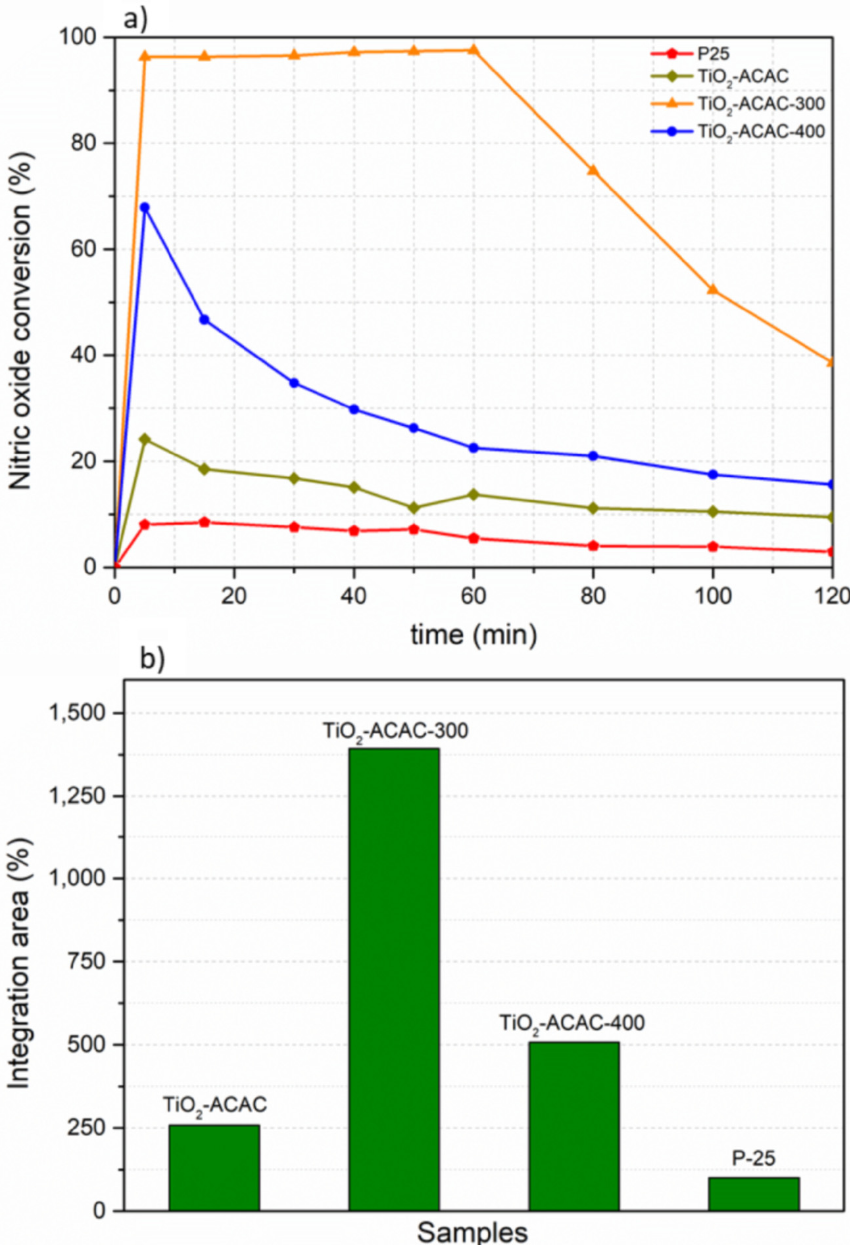
Figure 8. ( a ) Photocatalytic conversion of NO x as a function of time for TiO 2 -ACAC, TiO 2 -ACAC-300, TiO 2 -ACAC-400 and Evonik P-25; ( b ) histograms of photocatalytic activities obtained through the integration area approach [35] (Evonik P-25 activity has been used for comparison, being fixed at 100%).